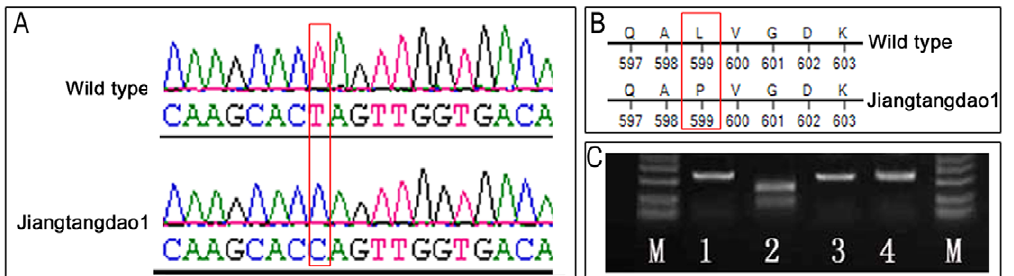
Figure 6. Sequence confirmation of the PCR products. A: Nucleotide ‘T’ of the wild type was substituted by ‘C’ of the mutant Jiangtangdao 1; B: The substitution resulted in a missense from Leu-599 of the wild in SBE3 coding region for 599 amino acid to Pro-599 of Jiangtangdao 1 in sbe3-rs coding for high resistant starch; and C Because the point mutation resulted in the loss of a restriction enzyme site Spe I, sbe3-rs of the mutant was not digested with Spe I, while SBE3 of the wild type was (M: marker DL2000; Lane 1–2: wild type before and after digestion; and lane 3–4: Jiangtangdao 1 before and after digestion).